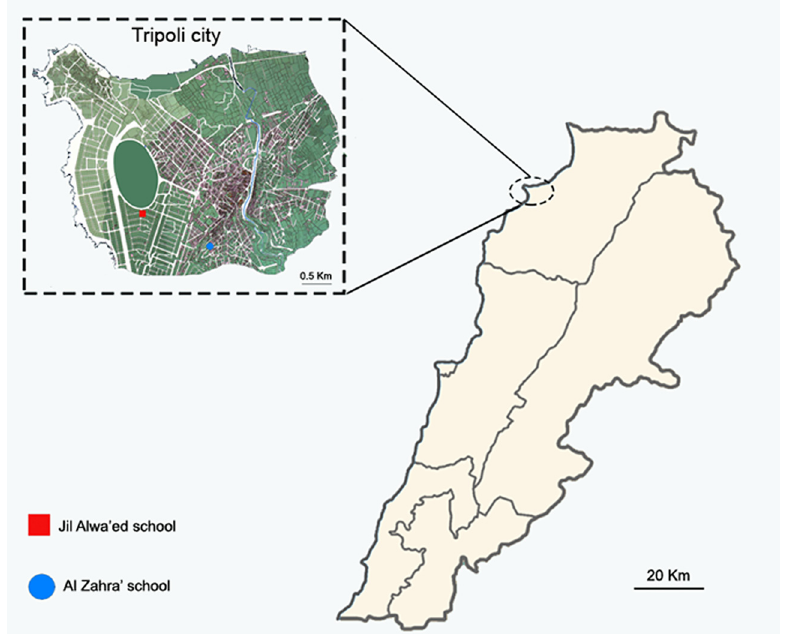
Fig 1. Map of Tripoli, showing the location of Al Zahra ’ and Jil Alwa ’ ed schools.